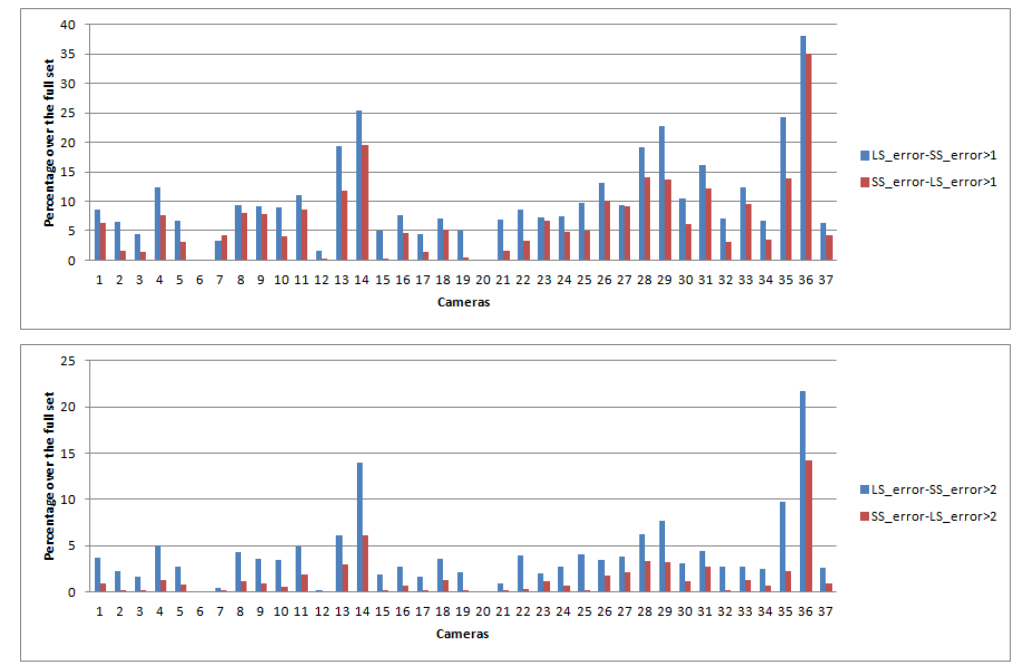
Figure 7. ( Top ) Blue bars: percentage of color signals where spherical sampling gives a lower error than least-squares by 1 ∆ E . Red bars: percentage of cameras where least-squares gives a lower error than spherical sampling by 1 ∆ E ; ( Bottom ) Blue bars: percentage of color signals where spherical sampling gives lower error than least-squares by 2 ∆ E . Red bars: percentage of cameras where least-squares gives lower error than spherical sampling by 2 ∆ E . The results show that our method obtains a perceptible improvement for around 3% more samples than least-squares for both cases.